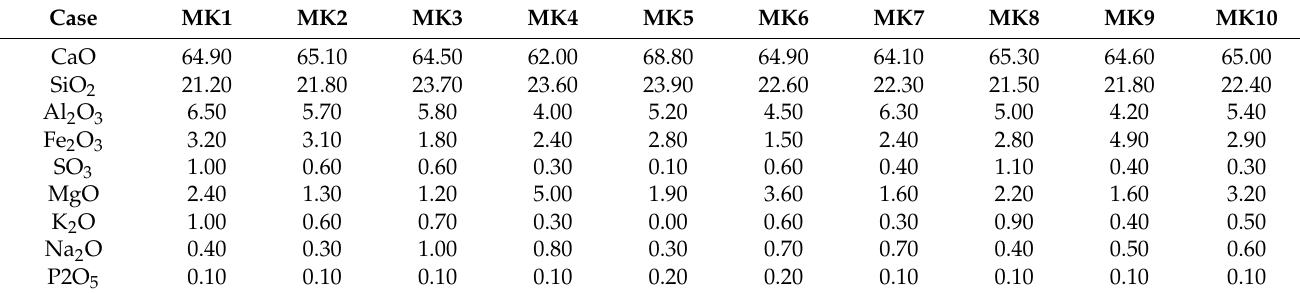
Table A1. Experimental Data Sets Collected from Previous Studies